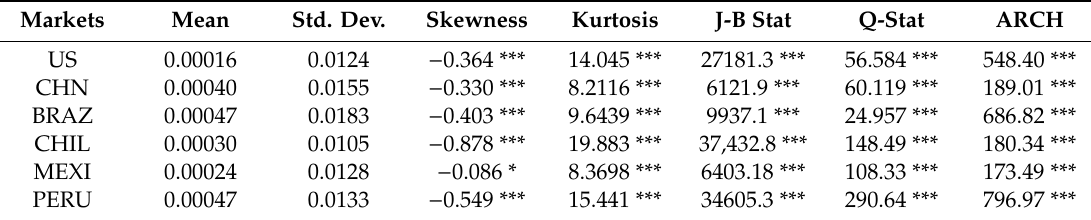
Table 1. Summary statistics.